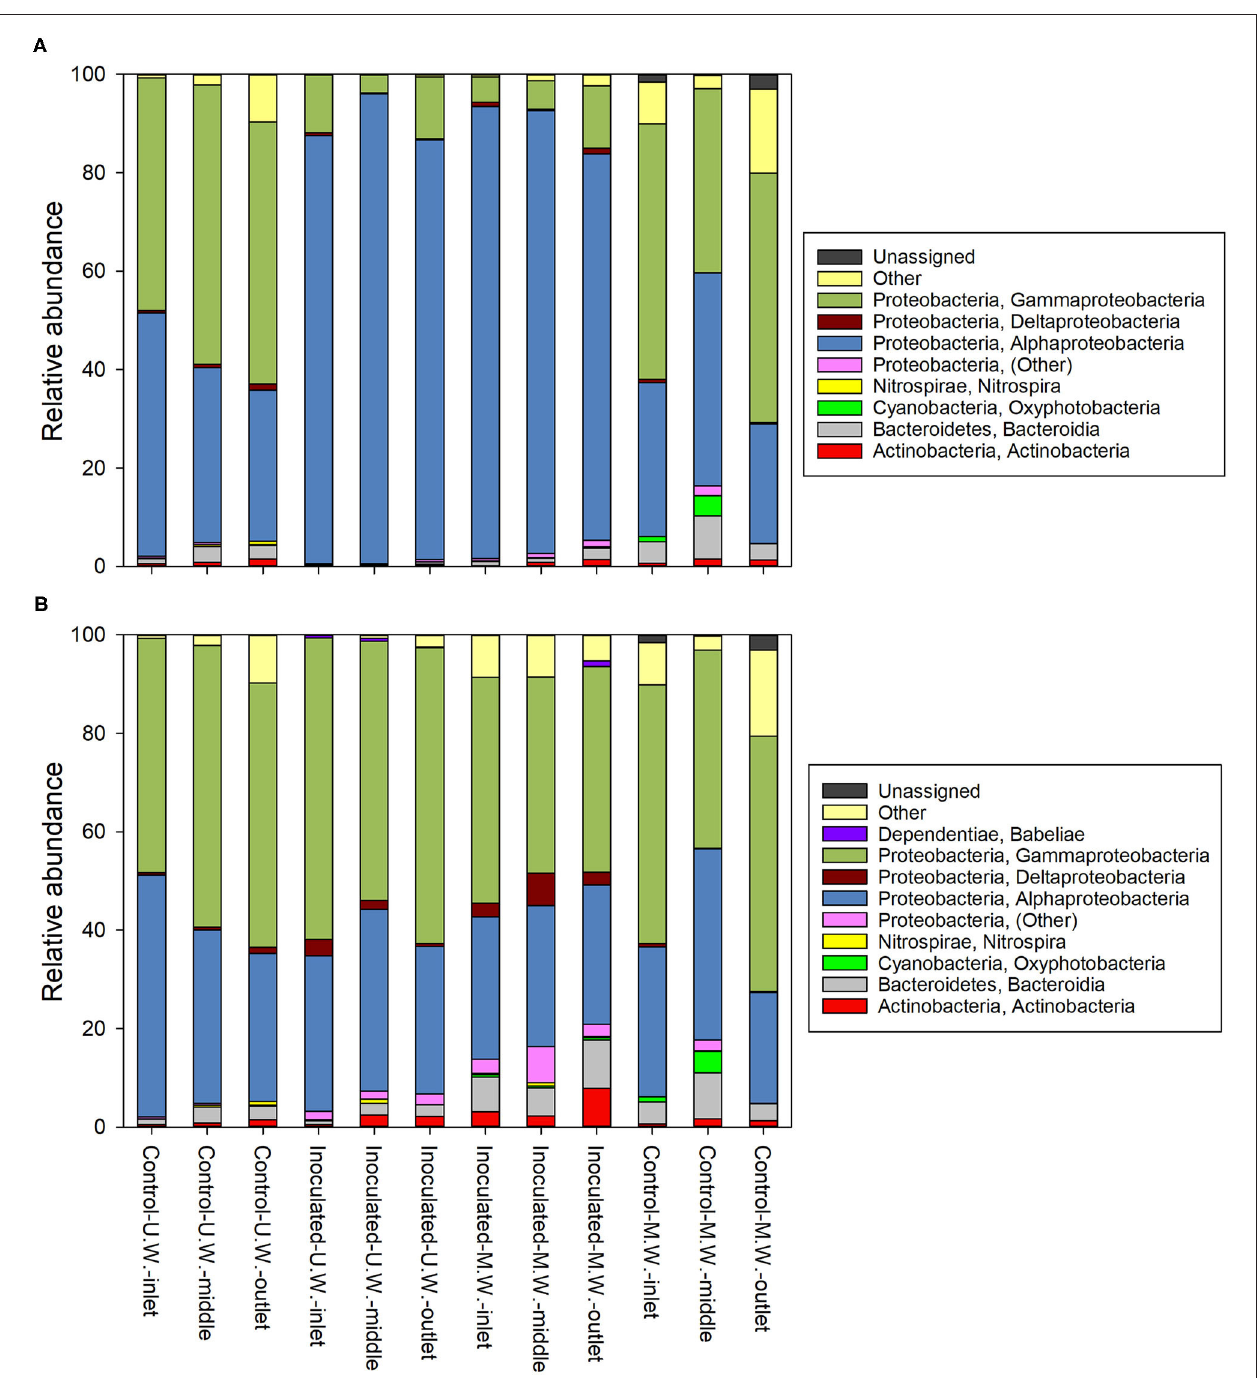
FIGURE 7 | Composition of the prokaryotic communities of the columns at day 40. (A) The relative abundances within the whole communities and (B) the relative abundances within the dataset where sequences with ≥ 97% similarity to Aminobacter sp. MSH1 had been removed. The boxes to the right show at class level the identities of the 16S rRNA genes that had an accumulated relative abundance of > 1% across all samples. M.W.: Columns receiving membrane retentate water. U.W.: Columns receiving untreated water.